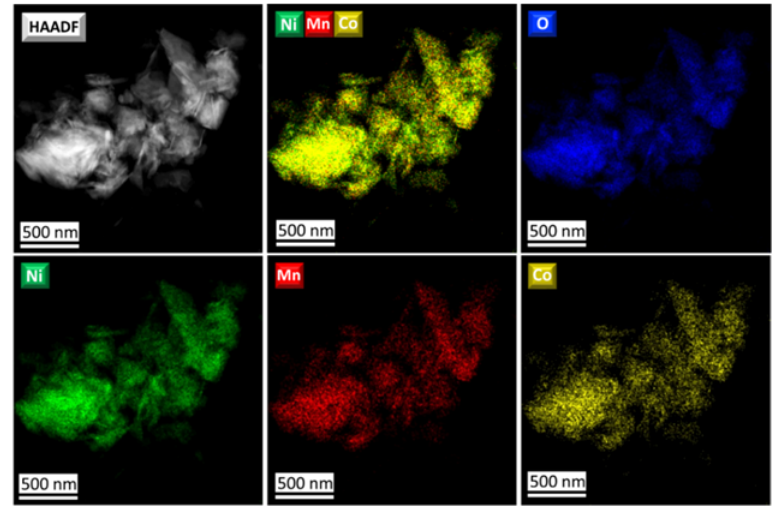
Figure 3. HAADF-STEM image of the MW_30m hydroxide precursor along with the corresponding color-coded STEM-EDX compositional map and elemental maps of O, Ni, Mn, and Co.